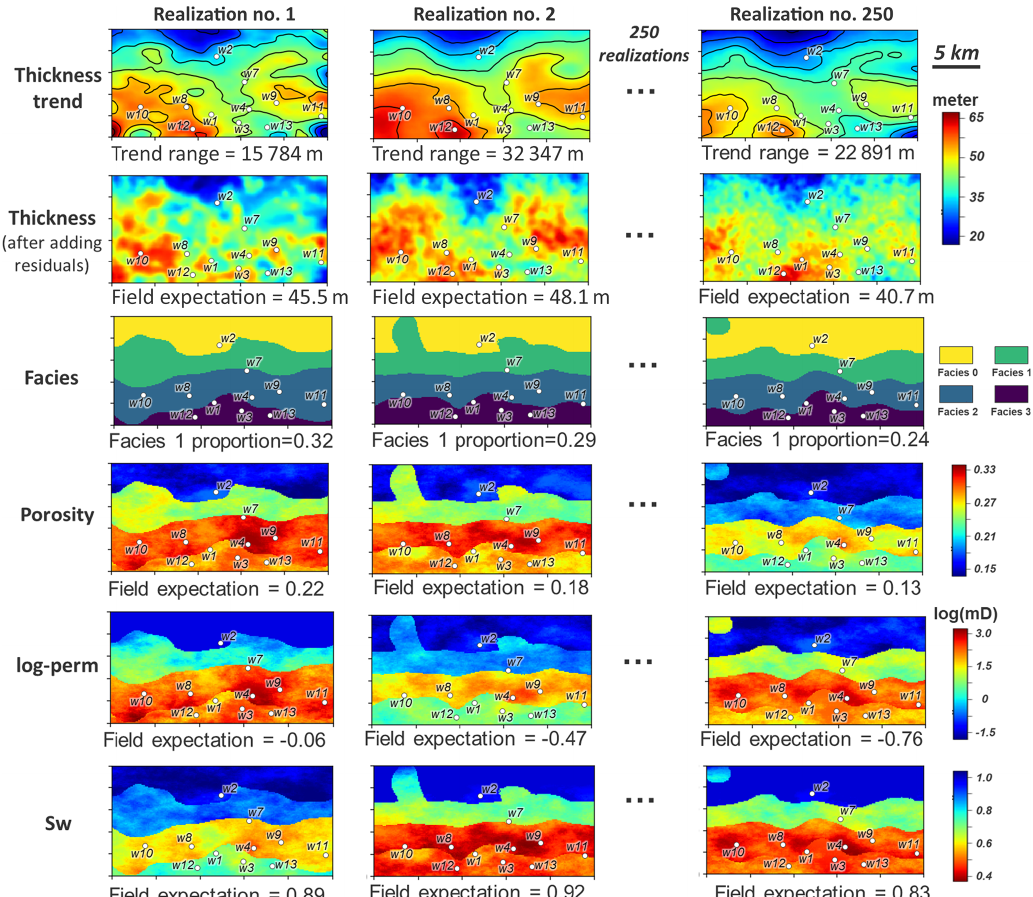
Figure 6. Layer view of prior Monte Carlo model samples of thickness trend and corresponding thickness, facies, porosity, permeability (logarithmic, termed log-perm), and